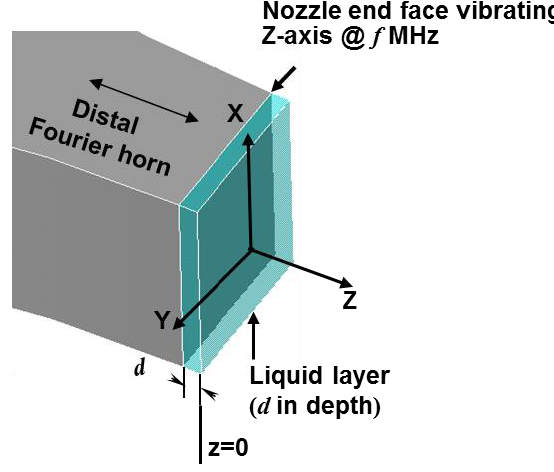
Figure 5. Rectangular coordinate system associated with liquid layer resting on the nozzle tip.